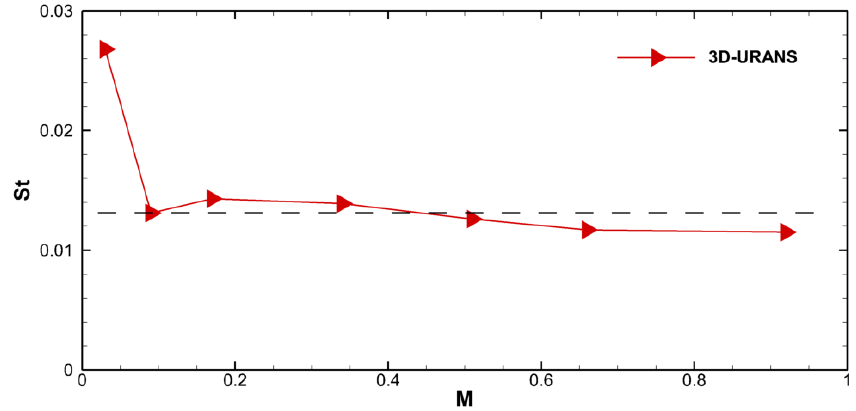
Figure 15. Strouhal number of the oscillating jet. ( St ave = 0.0131